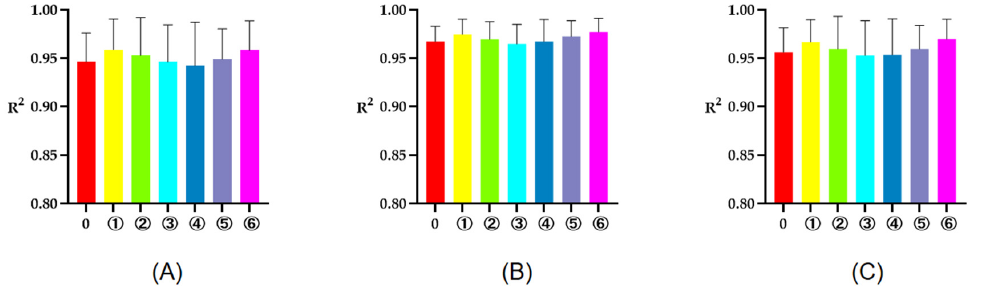
Figure 3. The R 2 of fitted curve of DM, CP and OM of roughages of 5 or 7 time points. ( A – C ), respectively, represent the R 2 of fitted curve of DM, CP, and OM in the rumen of roughages. The number 0 = 7 incubation time points, 1 (cid:13) , respectively, the R 2 of fitted curve of 4, 16, 36, 48, 72 h; 2 (cid:13) , respectively, the R 2 of fitted curve of 4, 16, 24, 48, 72 h; 3 (cid:13) , respectively, the R 2 of fitted curve of 4, 16, 24, 36, 72 h; 4 (cid:13) , respectively, the R 2 of fitted curve of 4, 8, 16, 24, 72 h; 5 (cid:13) , respectively, the R 2 of fitted curve of 4, 8, 16, 36, 72 h; 6 (cid:13) , respectively, the R 2 of fitted curve of 4, 8, 16, 48, 72